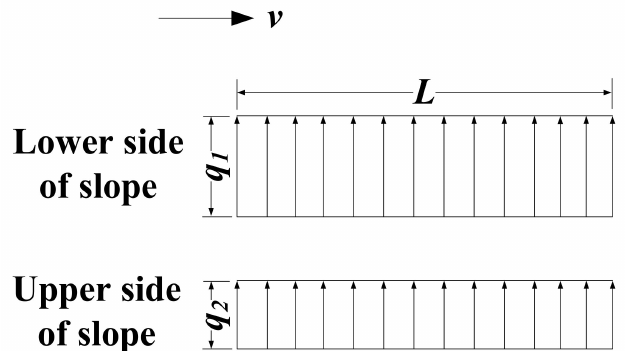
Figure 15. The normal direction load distribution of the track on the upper and lower sides of the lateral